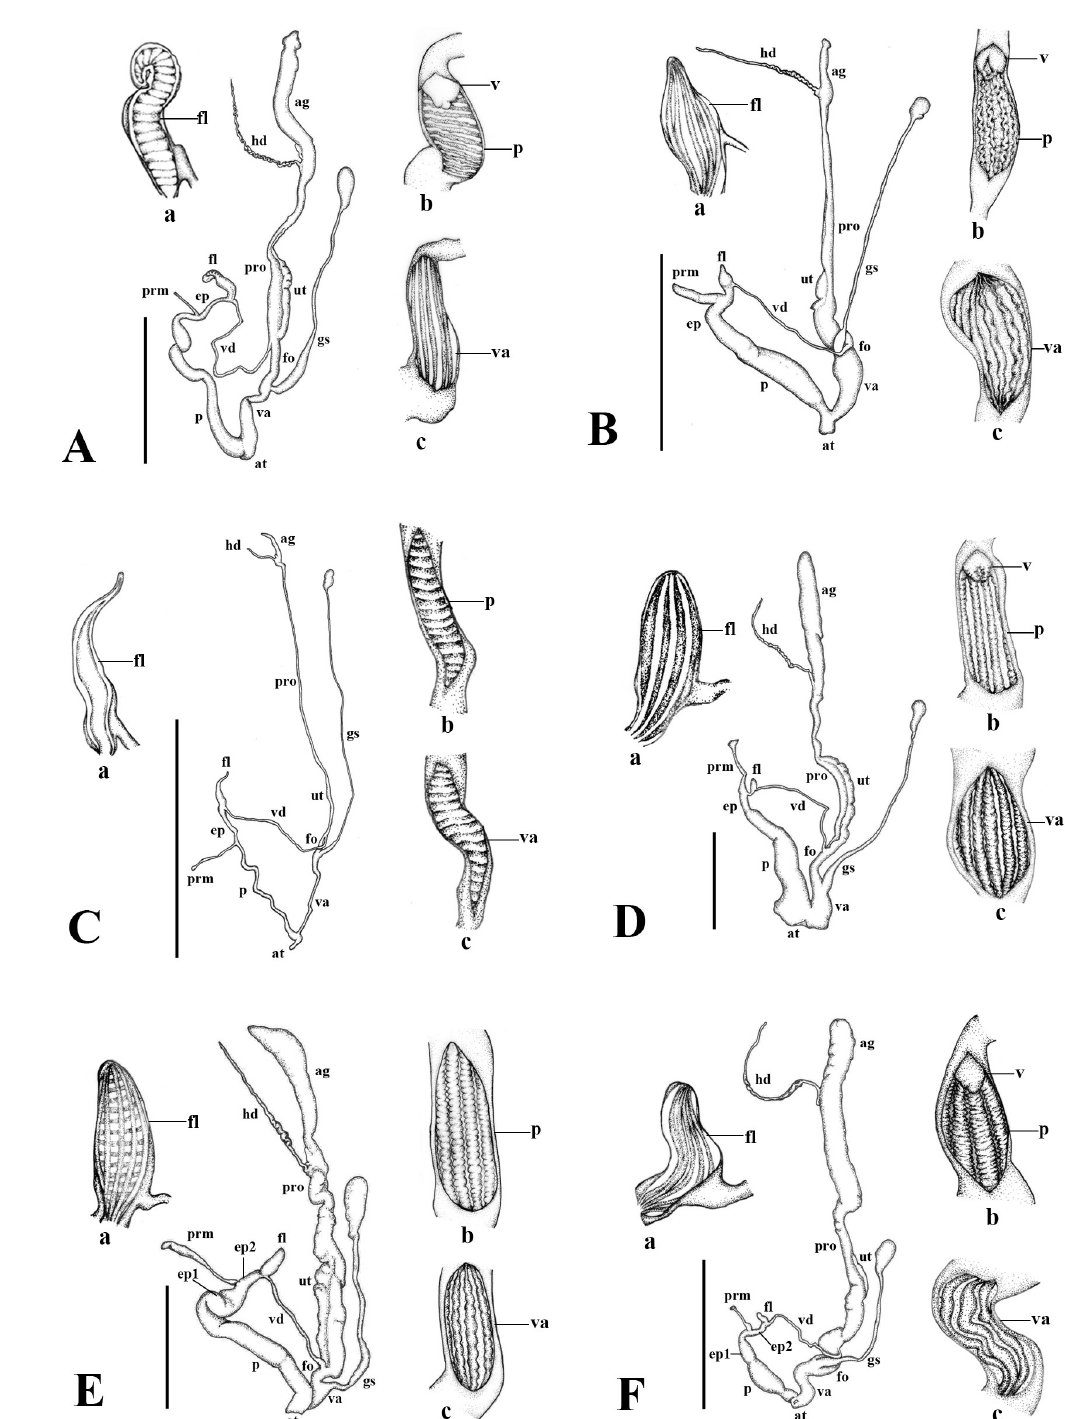
Fig. 5. Illustrations of the genital system of Landouria spp. from northeastern Thailand. A . Landouria circinata sp. nov., paratype (NHMSU-00024). B . L. tuberculata sp. nov., paratype (NHMSU-00026). C . L. trochomorphoides sp. nov., paratype (NHMSU-00028). D . L. chloritoides sp. nov., paratype (NHMSU-00030). E . L. elegans sp. nov., paratype (NHMSU-00033). F . L. diplogramma (Möllendorff, 1902) comb. nov. (NHMSU-00034). Internal sculpture of a = flagellum; b = penis; c = vagina. Scale bars = 10